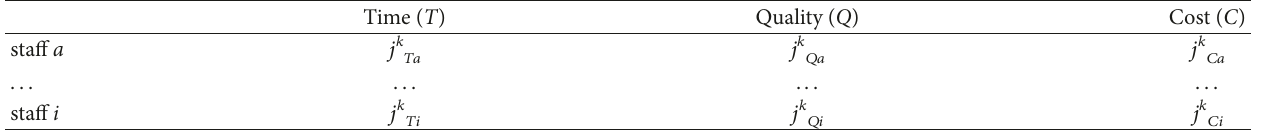
Table 2: The predictive value of the activity by a